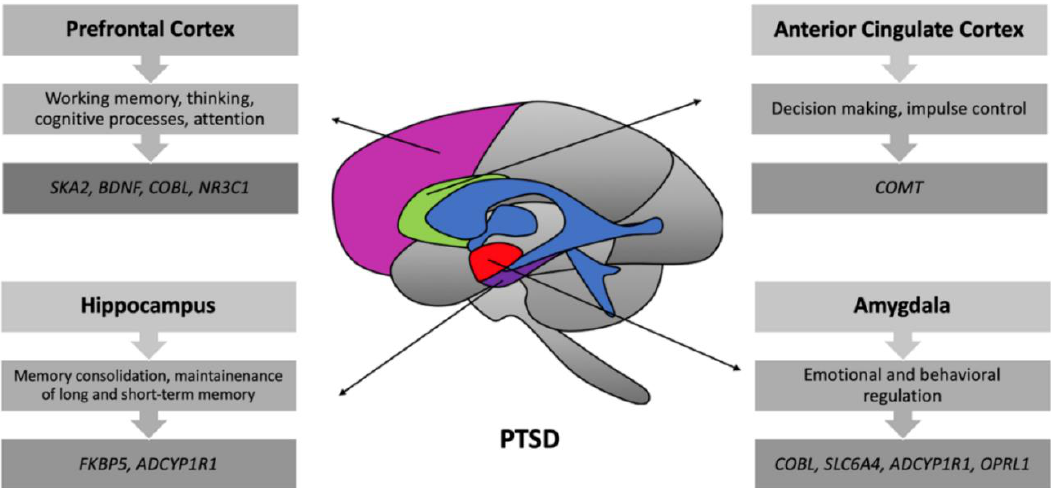
Figure 2. Genes associated with di ff erent brain regions in PTSD. In PTSD, genes such as SKA2 , BDNF , COBL , and NR3C1 are found to be associated with changes in the prefrontal cortex which is mainly involved in working memory processes. COMT is associated with changes in the anterior cingulate cortex (ACC) involved in the process of decision-making. FKBP5 and ADCYPIR1 are identified as being related to the hippocampal region, which plays an essential role in the maintenance of memory. Genes such as COBL , SLC6A4 , ADCYPIR1 , and OPRL1 were associated with the amygdala that plays a vital role in the processes of emotional regulation.